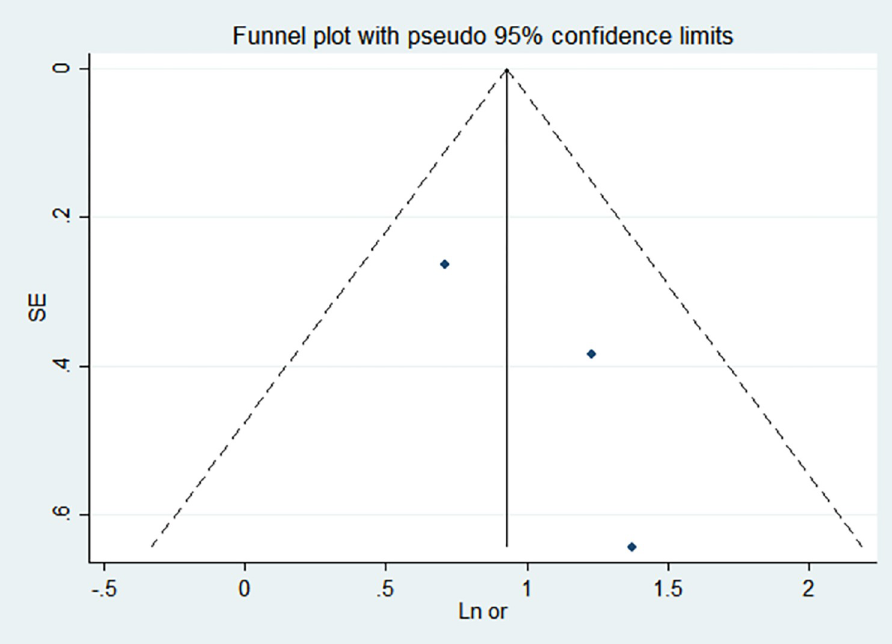
Fig 14. Funnel chart of septicemia.